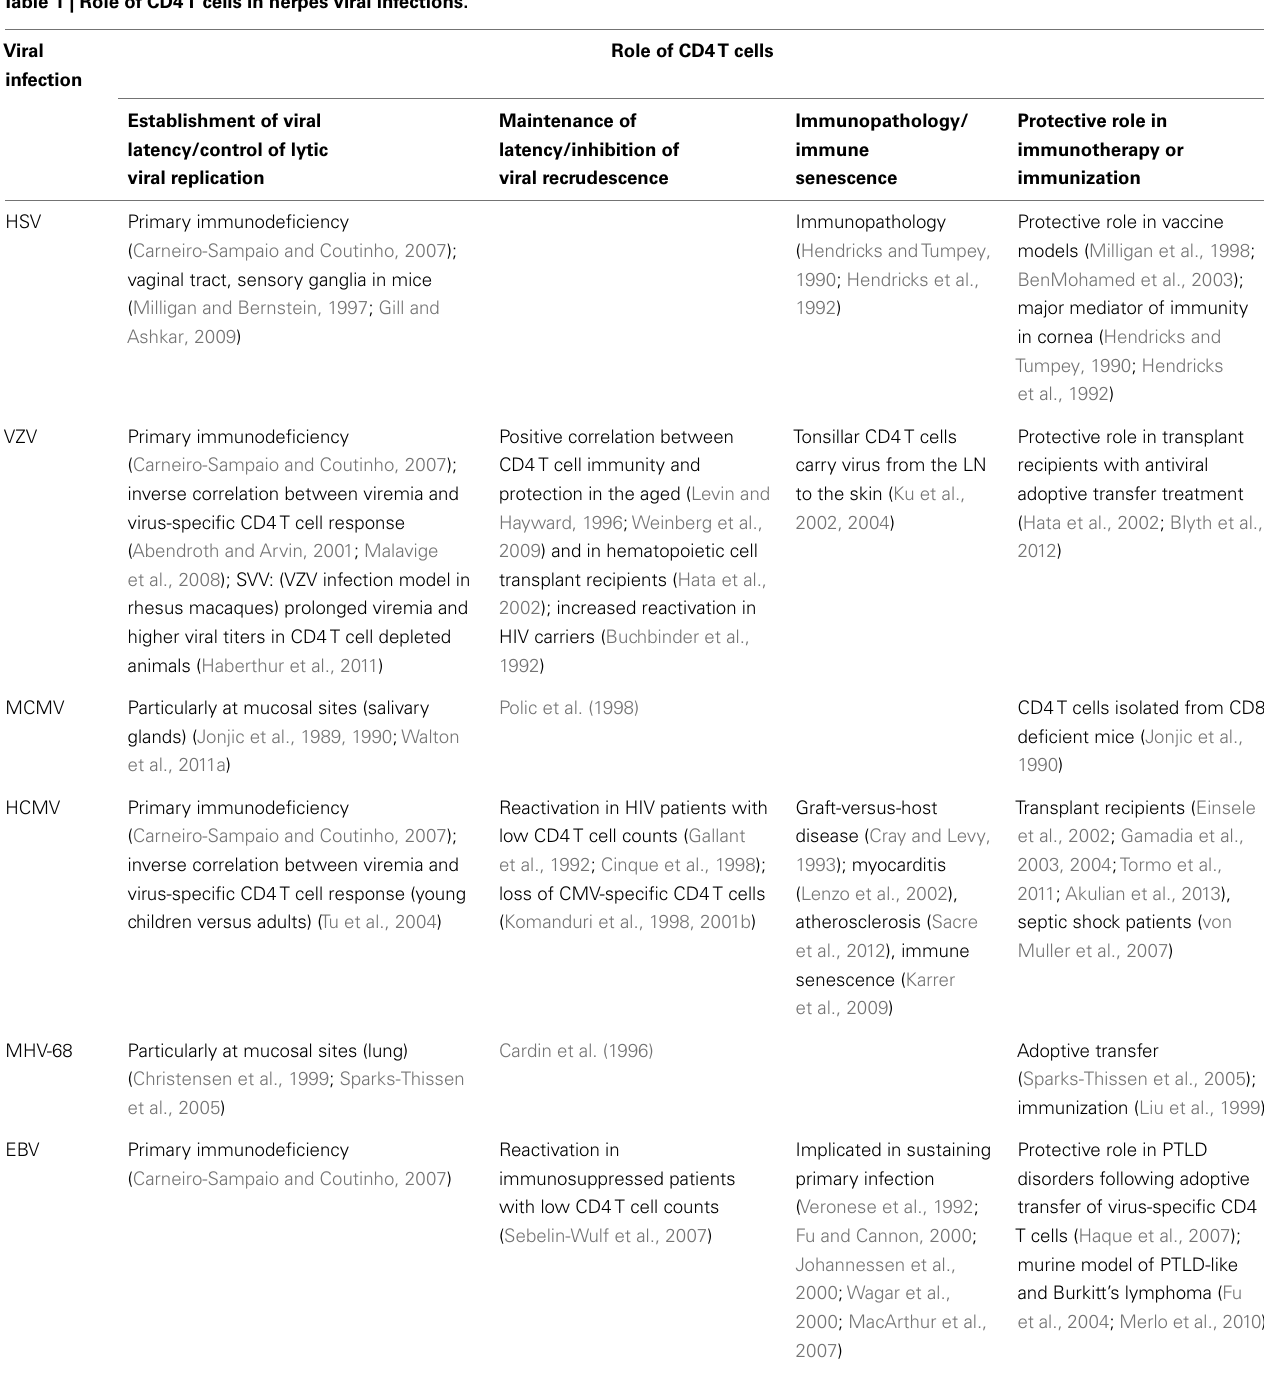
Table 1 | Role of CD4T cells in herpes viral